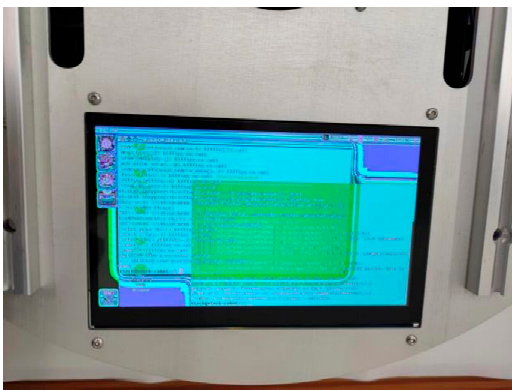
Figure 11. Unmanned vehicle screen blurred.